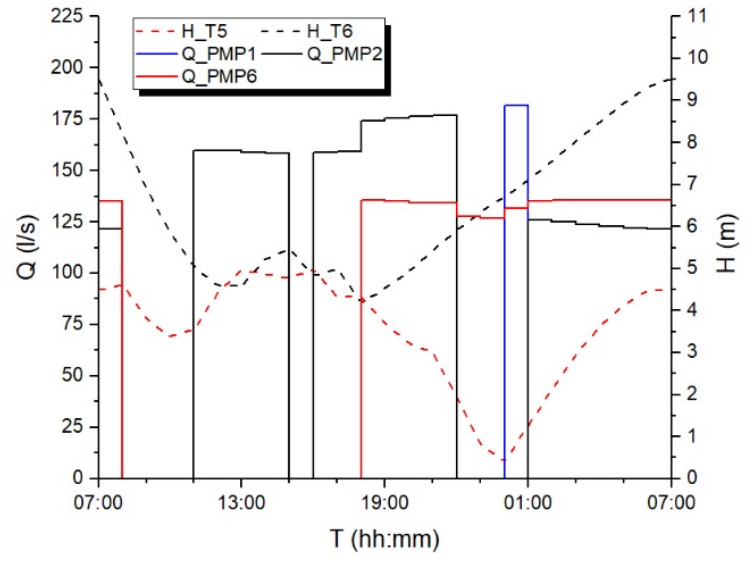
Figure 4. Results of the pump scheduling methodology by [10] for Van Zyl network, hydraulic time-step 1 h.